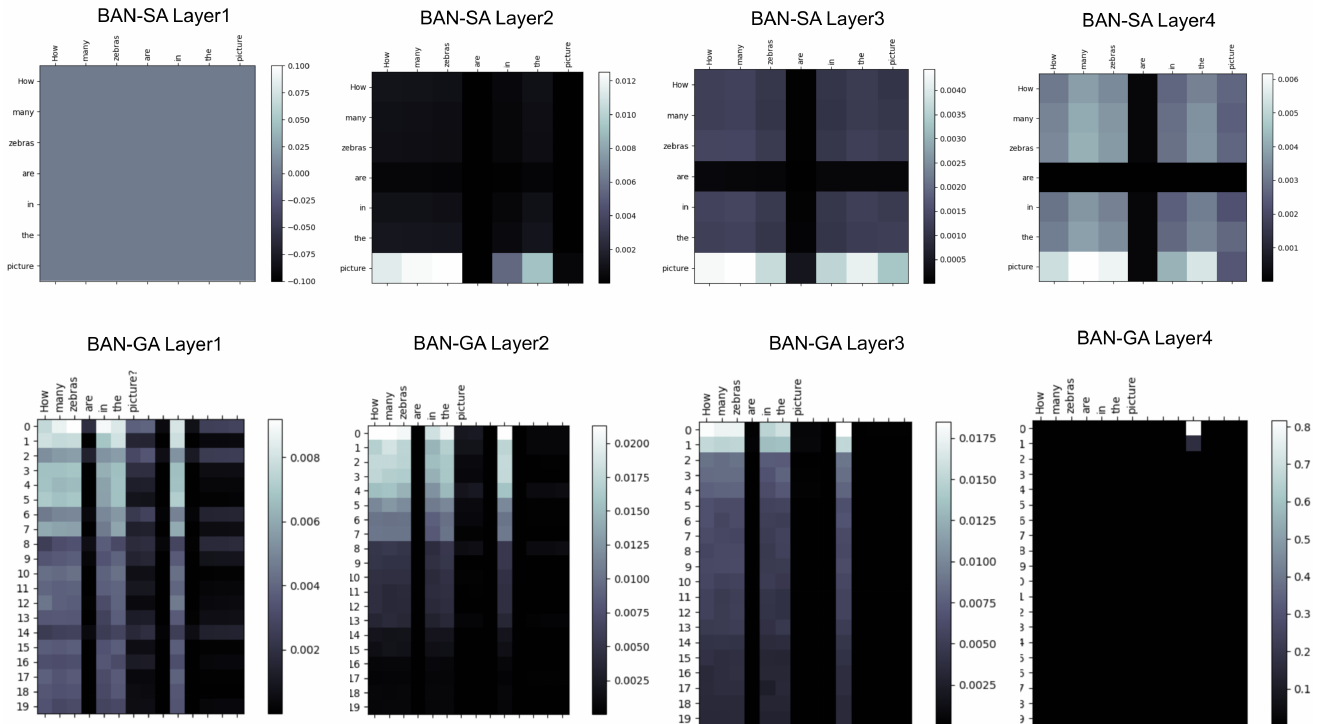
Figure 8. We set the number of layers of the model to 4. Visualizations of the attention maps of the BAN-SA and BAN-GA in each layer. BAN-GA and BAN-SA respectively denote Bilinear Guided-Attention Network and Bilinear Self-Attention Network.